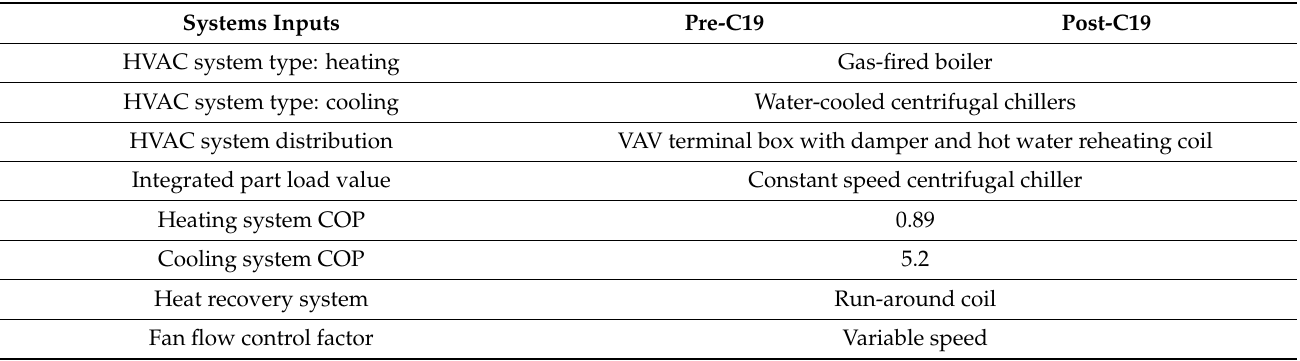
Table 9. Summary of Cove.tool systems inputs in pre- and post-C19